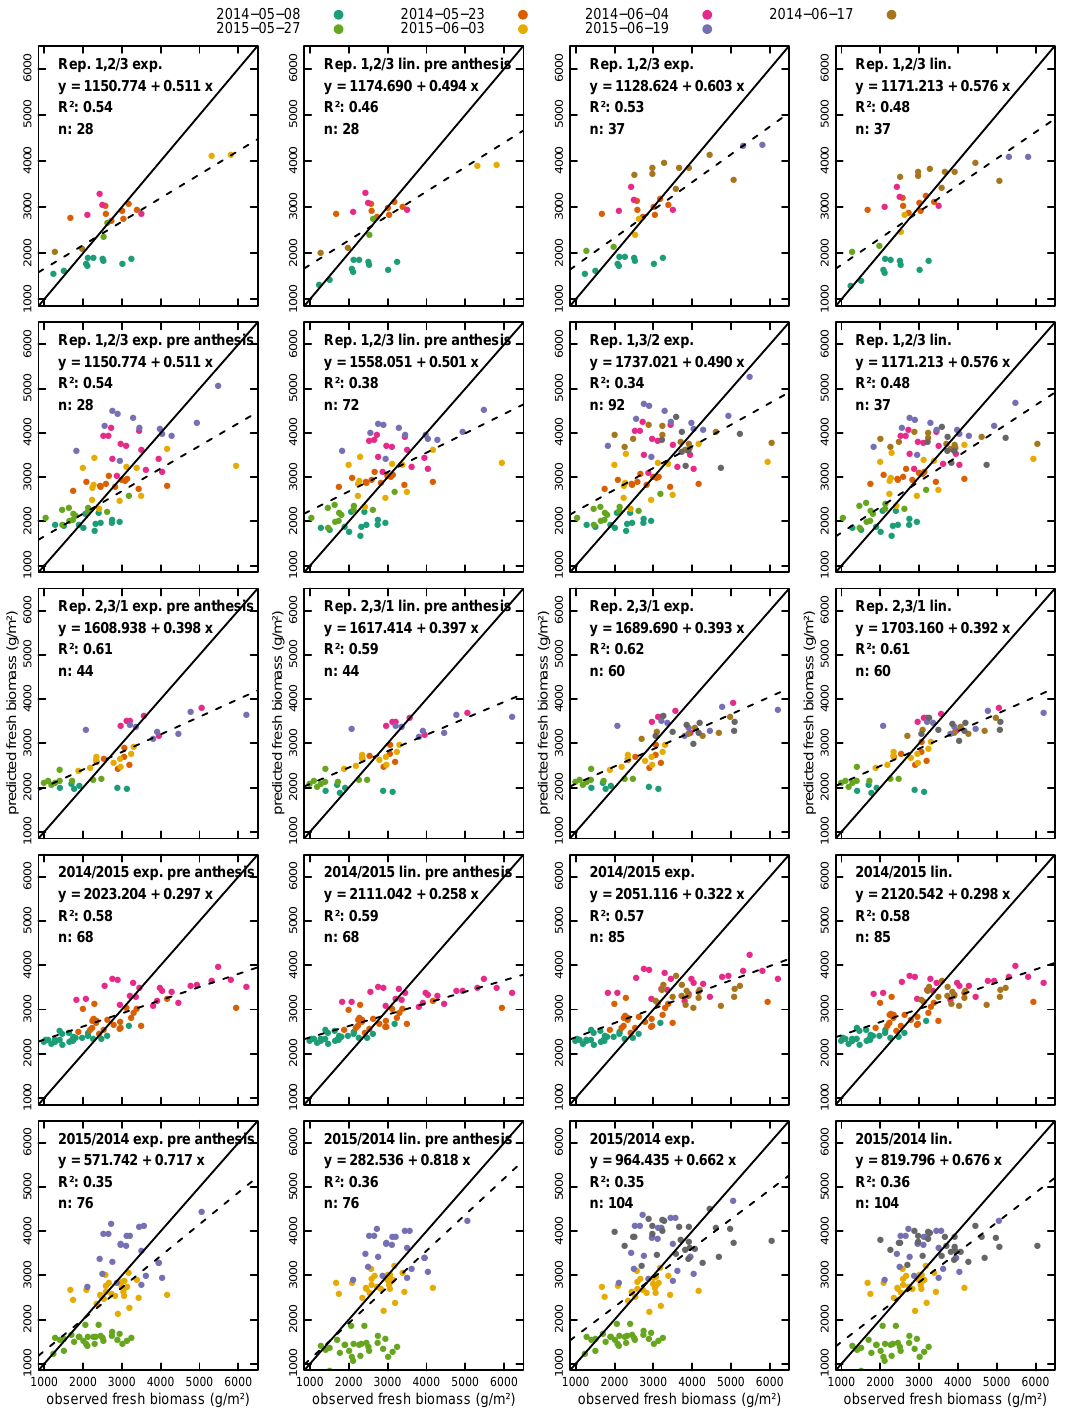
Figure 6. Observed vs. predicted fresh biomass. The solid line is the 1:1 line, and the dashed line is the regression